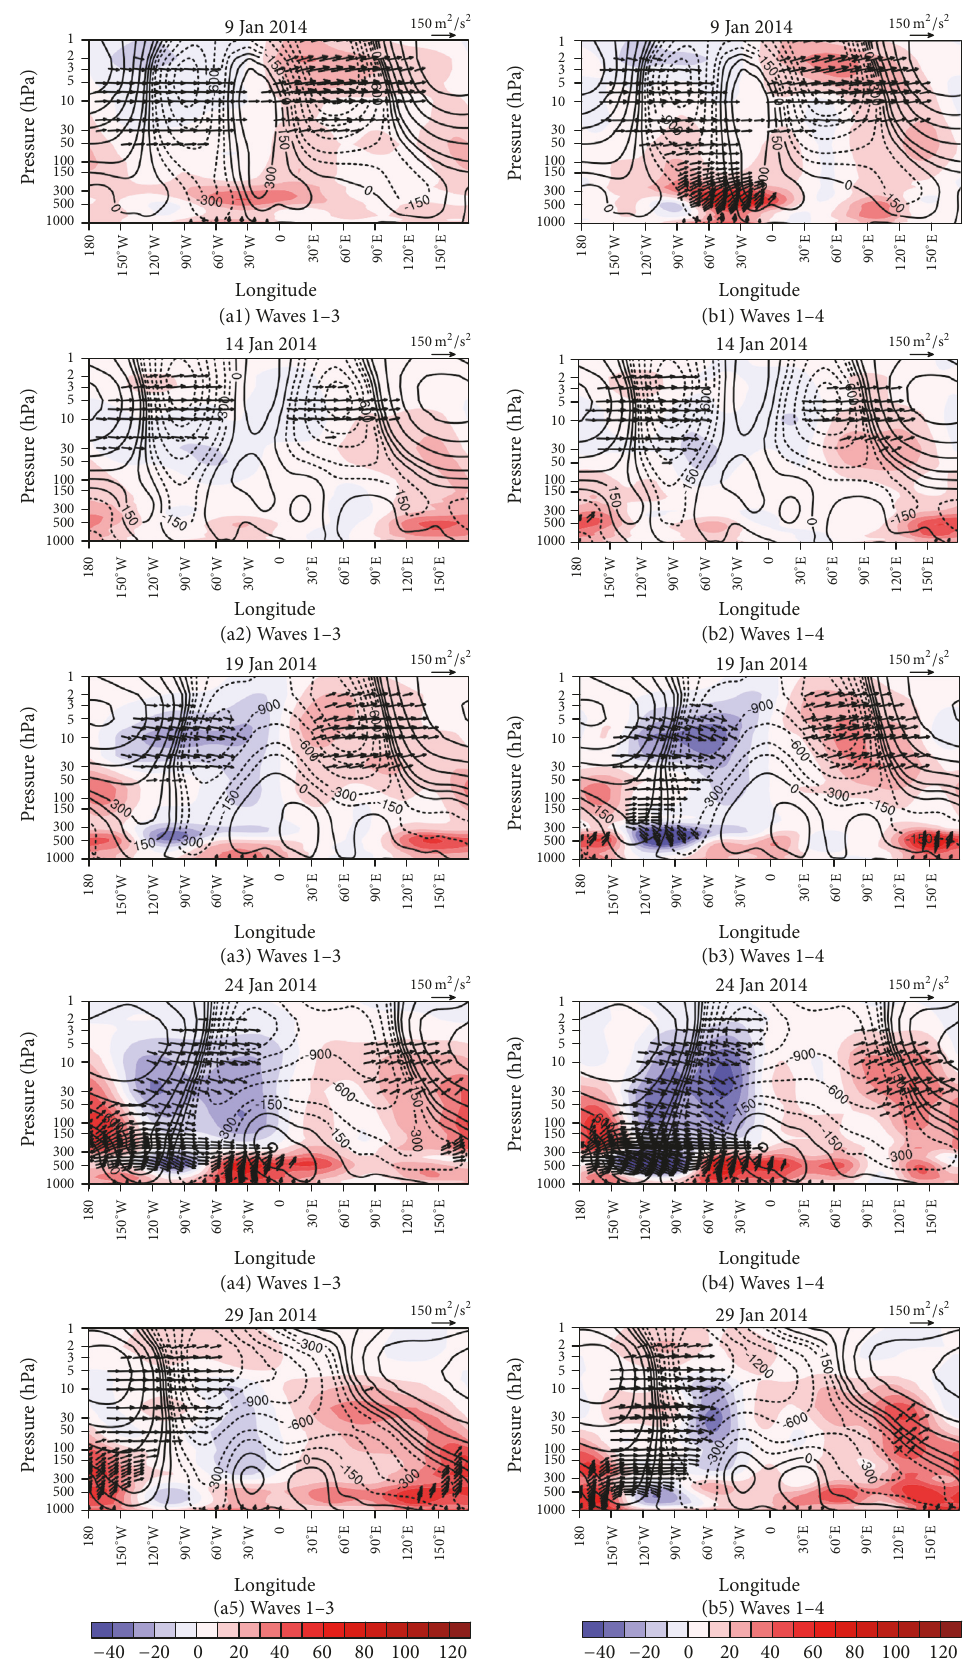
Figure 6: As in Figure 5 ((a1)–(a5)), but for waves 1–3 ((a1)–(a5)) and waves 1–4